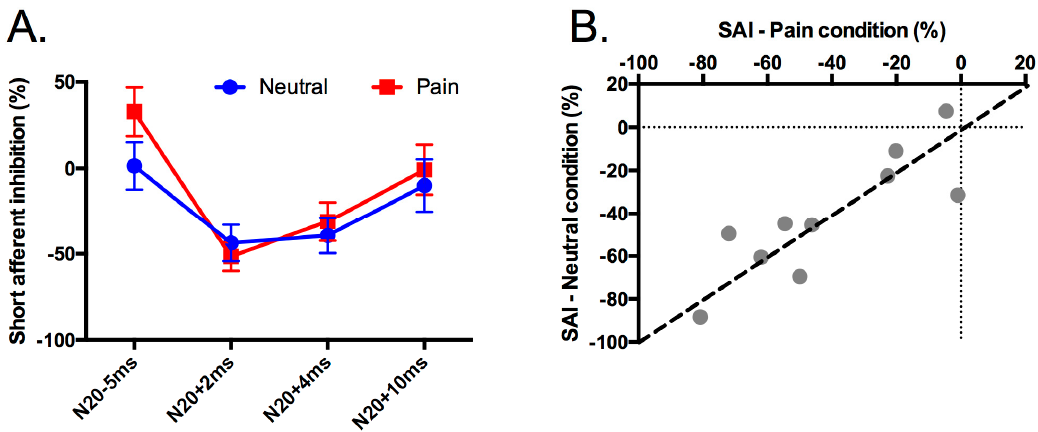
Figure 4. Percentage change in MEP amplitude. ( A ) The amount of SAI (percentage change in MEP amplitude) separately for each ISI for the NEUTRAL (Blue) and PAIN (Red) conditions. ( B ) The average amount of SAI at N20+2 and N20+4 in the NEUTRAL condition versus the PAIN condition. These two ISIs were averaged because they were significantly different from MEP test (see [20] for a similar approach).